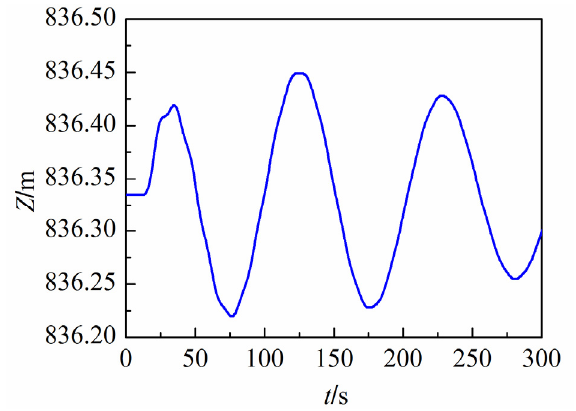
Figure 39. Water level fluctuation in surge tank #3 for Case 2.